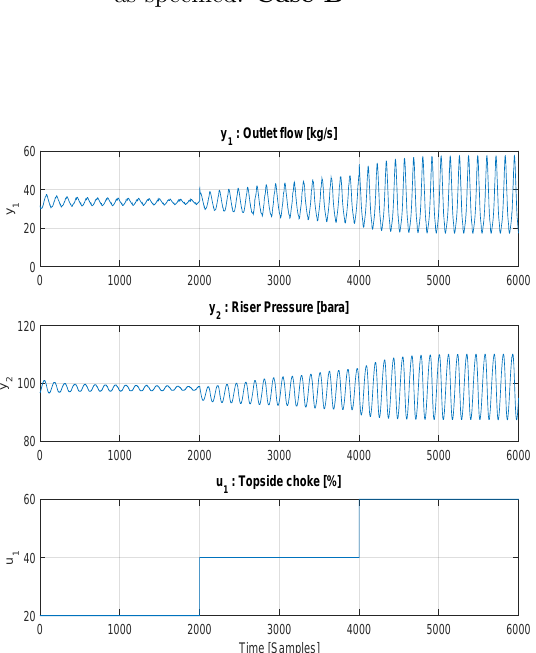
Figure 13: LQR controlling the identified 5th order model with Q = 1 and P = 500 I 2 × 2 . LQR introduced at Time = 1000 Samples. For Time > 5000, the Subsea choke, u 2 , satu- rates, because of the bound 22 < u 2 ≤ 45, as specified. Case B